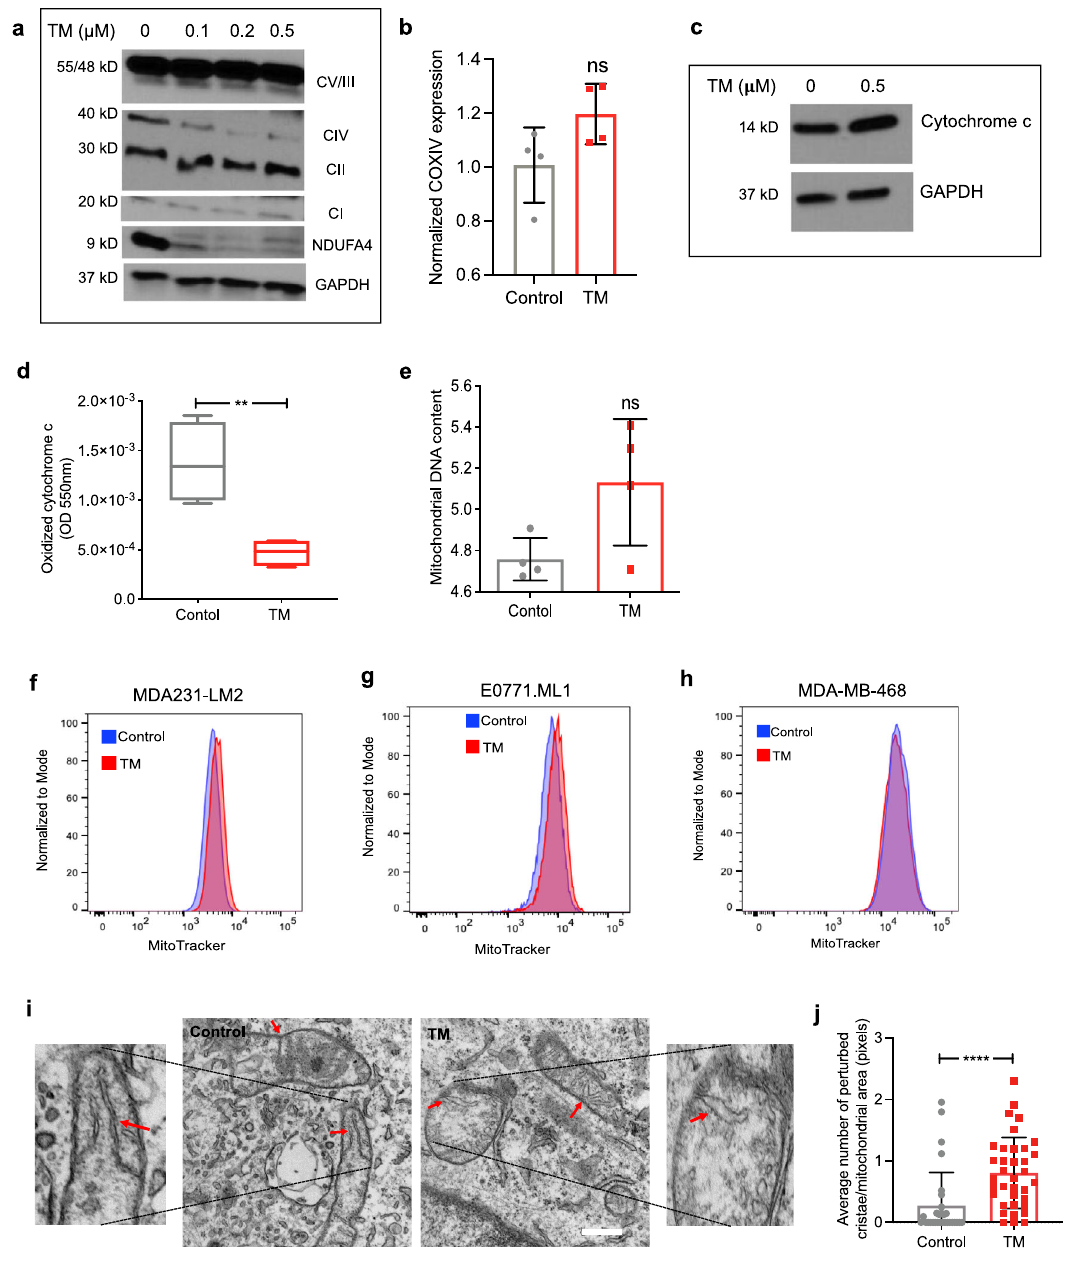
Fig. 3 TM treatment impacts mitochondrial Complex IV. a Western blot showing respiratory complexes in LM2 cells following 72-h TM treatment (0, 0.1, 0.2, 0.5 µ M). Complexes I – V are referred to as CI (mol. wt. ~19 kDa), CII (mol. wt. ~30 kDa), CIII (mol. wt. ~48 kDa), CIV (mol. wt. ~40 kDa), and CV (mol.wt. ~55 kDa), respectively. NDUFA4 is a subunit of Complex IV. b qPCR analysis showing transcript levels of human Complex IV subunit 4I1 (COX4I1) in control and TM (0.5 µ M) treated LM2 cells, treated with TM for 72 h. Analysis was performed by unpaired two-sided t -test. p -value = 0.079. c Protein expression of cytochrome c with and without TM treatment (0.5 µ M) ( n = 4/group). d Human cytochrome c oxidase activity (Abcam) kinetically measured over 2 h after 72 h of treatment with TM (0.5 µ M) in LM2 cells. The graph represents the difference in Complex IV activity at 110th minute during measurement. Analysis was performed by unpaired two-sided t -test ( n = 4/group). p -value = 0.0063. Center lines of box plots denote median values, top whiskers denote maxima and bottom whiskers minima. e Mitochondrial DNA content in LM2 cells as determined by qPCR ( p = 0.060). Analysis was performed by unpaired two-sided t -test ( n = 4/group). f – h MitoTracker deep red analysis in control and TM (0.5 µ M) treated LM2 ( f ), ML1 ( g ) and MDA-MB-468 ( h ) cells, treated for 72 h ( n = 3/group). i Structure of cristae in the inner mitochondrial membrane as determined by transmission electron microscopy (×50,000), red arrows indicate normal/folded and perturbed cristae morphology in LM2 cells. Scale bar, 500 nm. j Quanti fi cation of perturbed cristae per 100 units of mitochondrial area in pixels ( n = 30 mitochondria in controls, n = 36 mitochondria for TM group). Analysis was performed using Mann – Whitney two-sided test. Representative data of two independent experiments are depicted. Results are expressed as mean ± SD. ** p < 0.01 **** p <